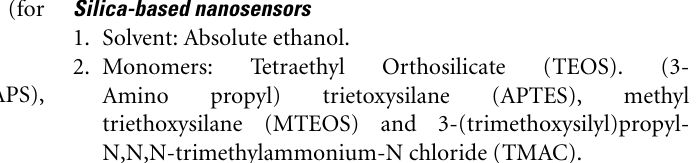
This effectively creates amask. (D) Themask issubsequently appliedtothe correspondingimageintheindicatorchannel. (E) Aratioofindicatortoreference intensityistakenforeachpixelwithinthemaskedregion. (F) Theratiosarethen weightedaccordingtotheintensityinthereferencechannel. (G) Theprocessis repeated over apHrange from2.5to8.0, andthemean intensityisutilizedto construct acalibration. (H) Anequation